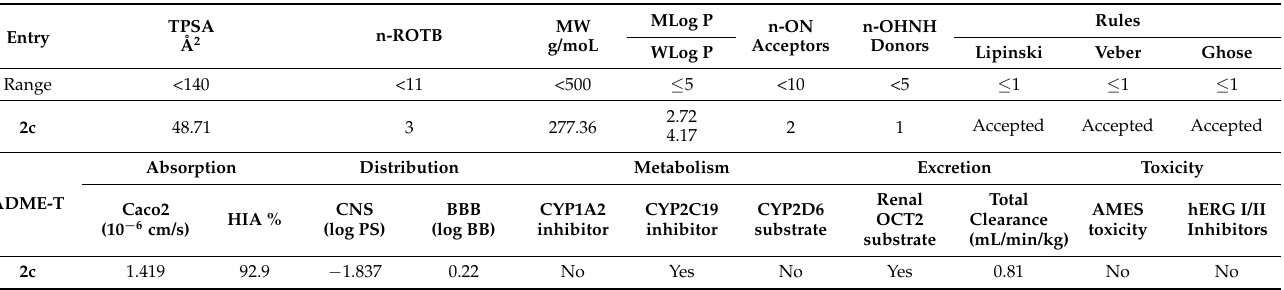
Table 7. ADME-T and drug-likeness properties of compound